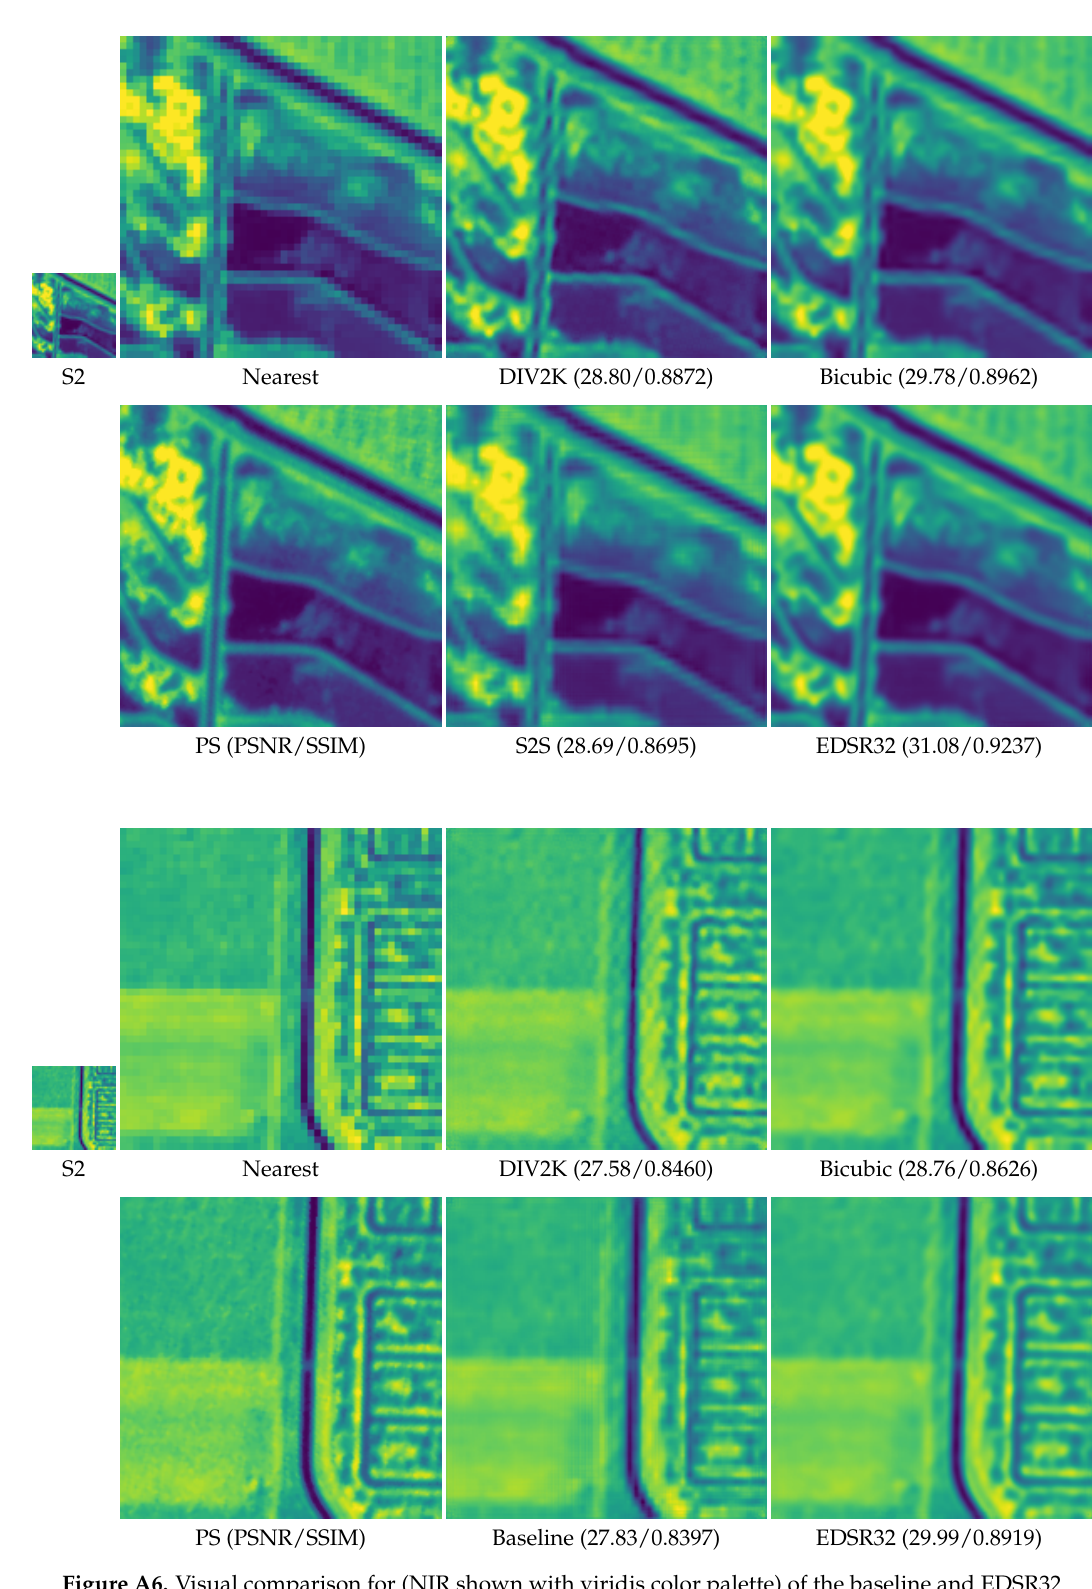
Figure A6. Visual comparison for (NIR shown with viridis color palette) of the baseline and EDSR32 models (tiles from test